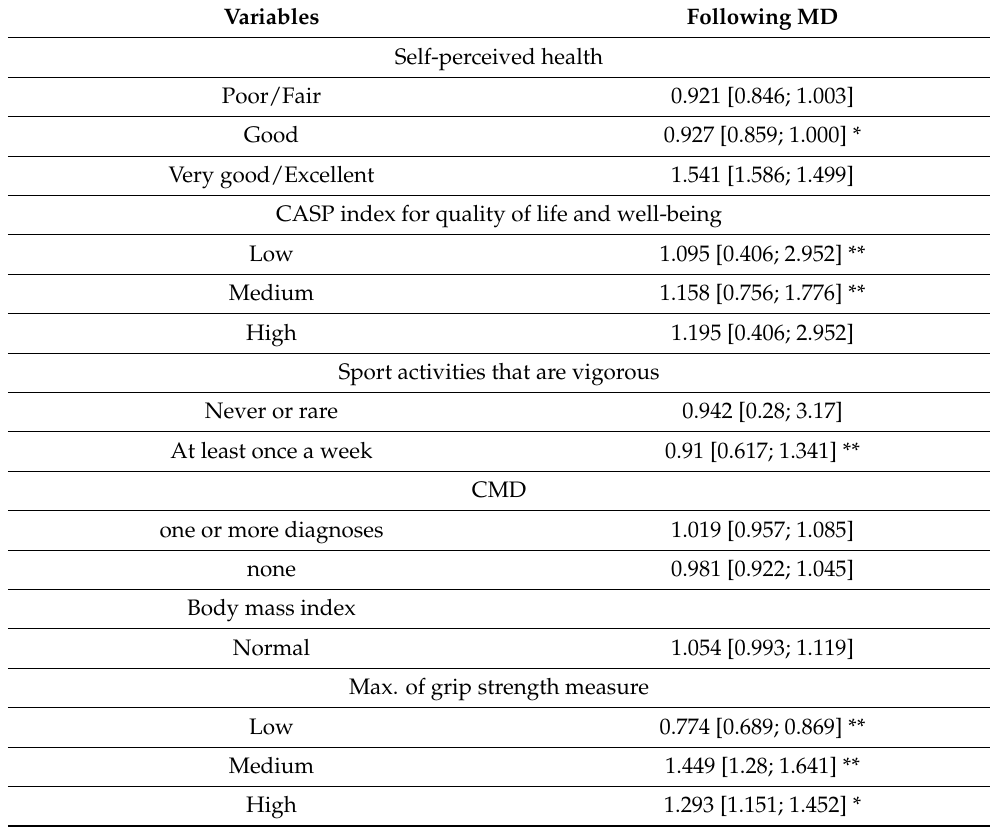
Table 5. Adjusted odds ratios (95% CI) for Mediterranean diet